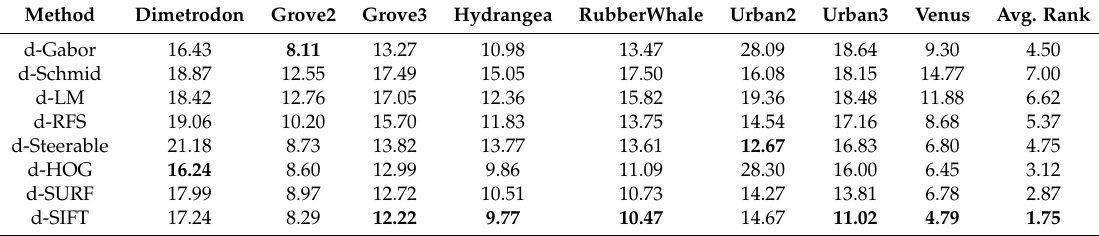
Table 2. Average Angular Error (AAE) comparison for training images of the Middlebury